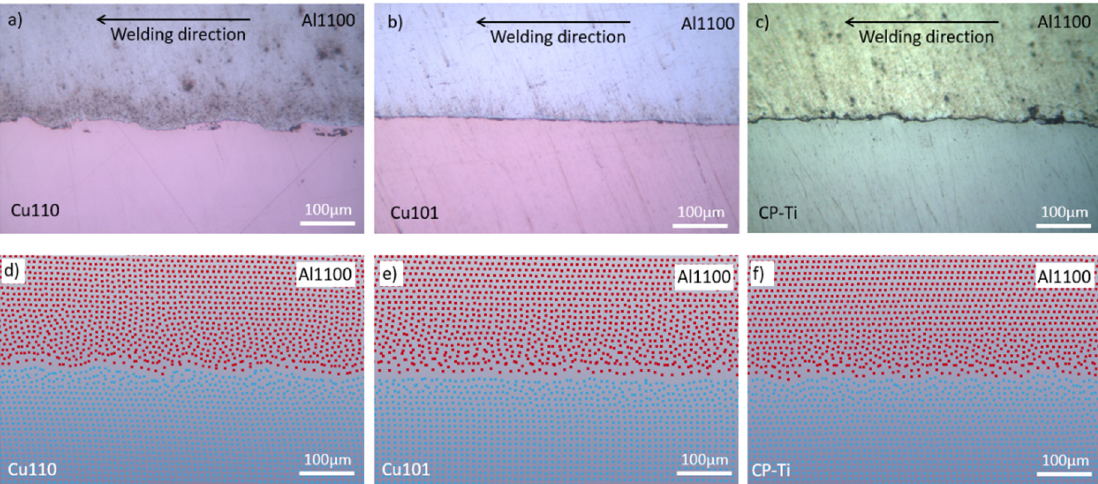
Figure 6. Interface morphology difference, experiments: ( a ) Al1100 & Cu110, ( b ) Al1100 & Cu101, ( c ) Al1100 & CP-Ti, SPH: ( d ) Al1100 & Cu110, ( e ) Al1100 & Cu101, ( f ) Al1100 & CP-Ti.